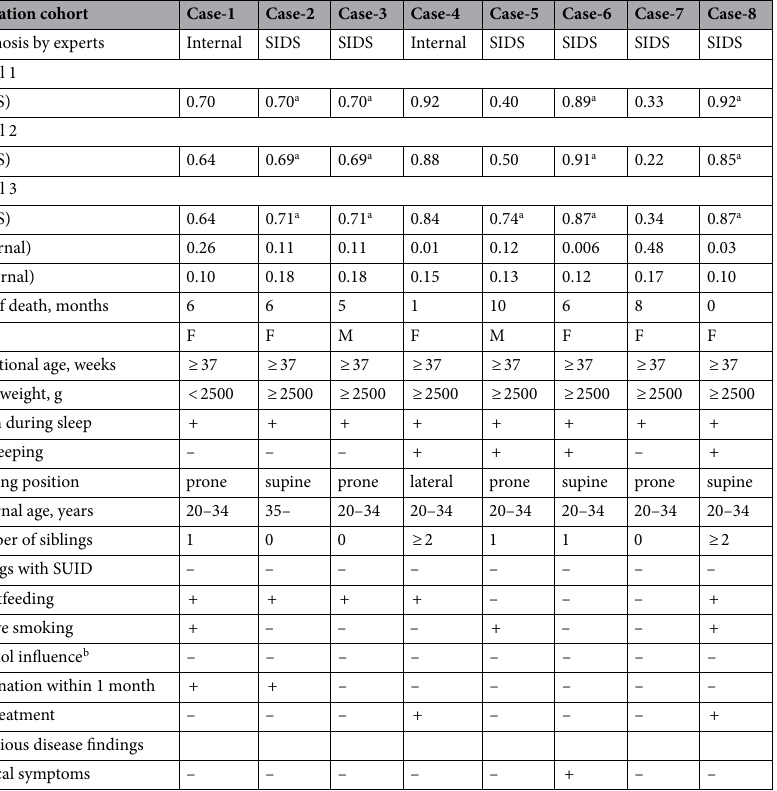
Table 4. Probabilities estimated by diagnostic support models in eight validation cases. a Diagnosis estimated with the highest probability matching the experts’ diagnosis. b Alcohol influence during childcare with caregivers. SIDS, sudden infant death syndrome; SUID, sudden unexpected infant